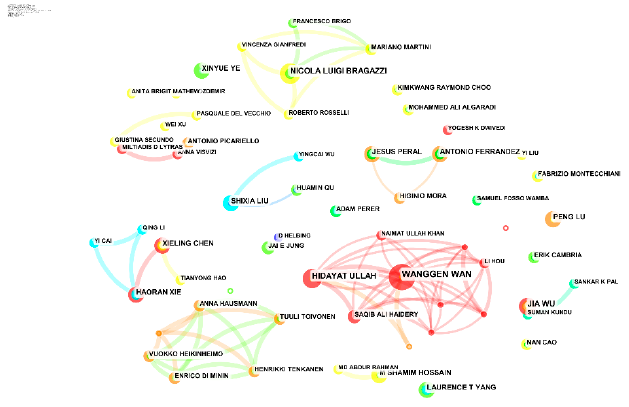
Figure 5. Knowledge map of author collaboration in SMBD.